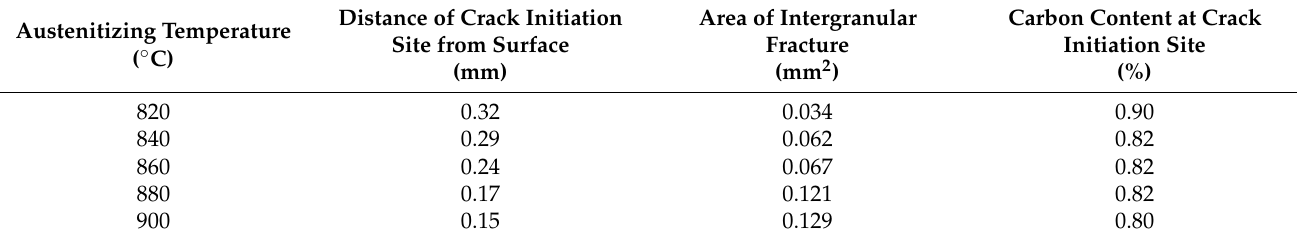
Table 4. Feature of the crack initiation site for the carburized